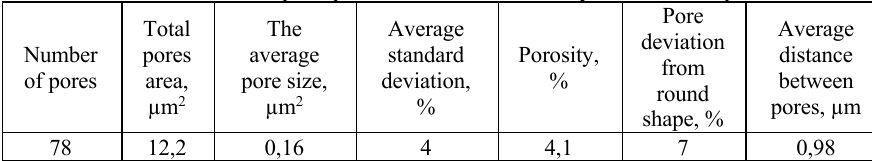
Table 1. Basic pore parameters determined by SEM